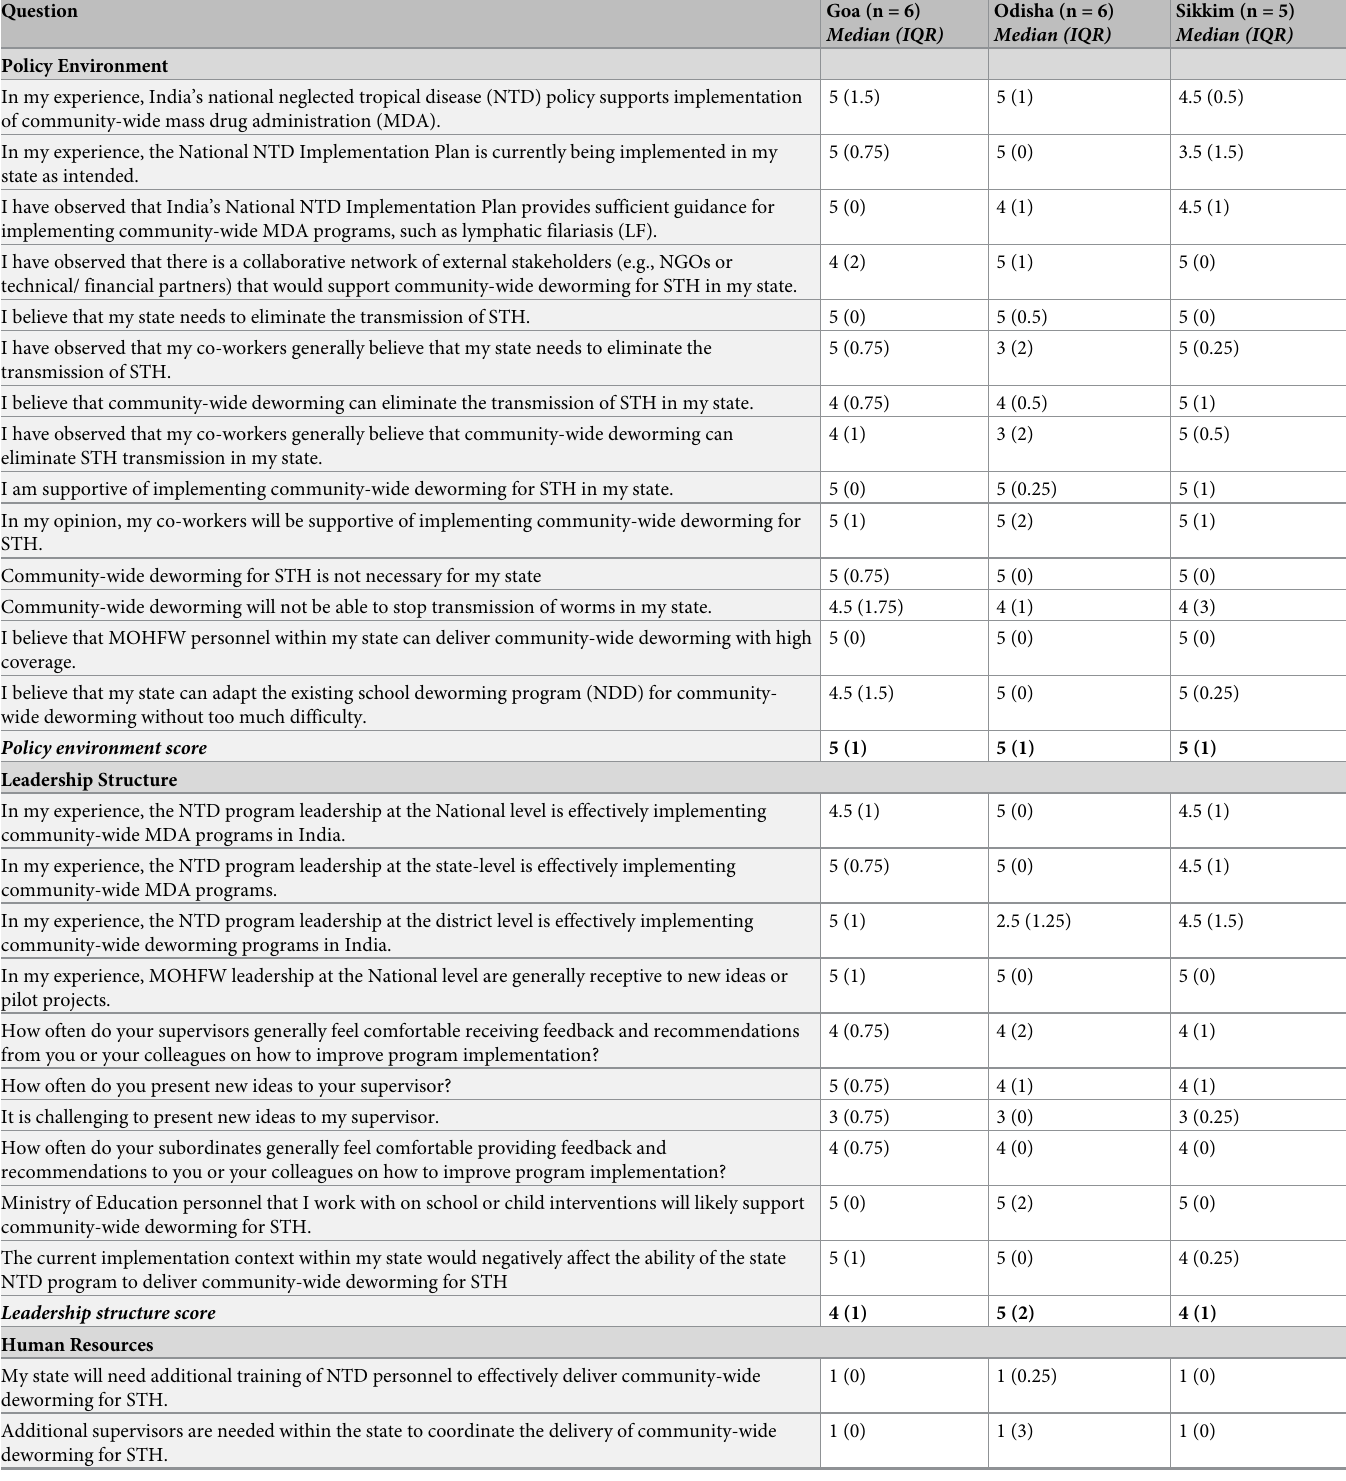
Table 3. Median and interquartile range for responses to organizational readiness